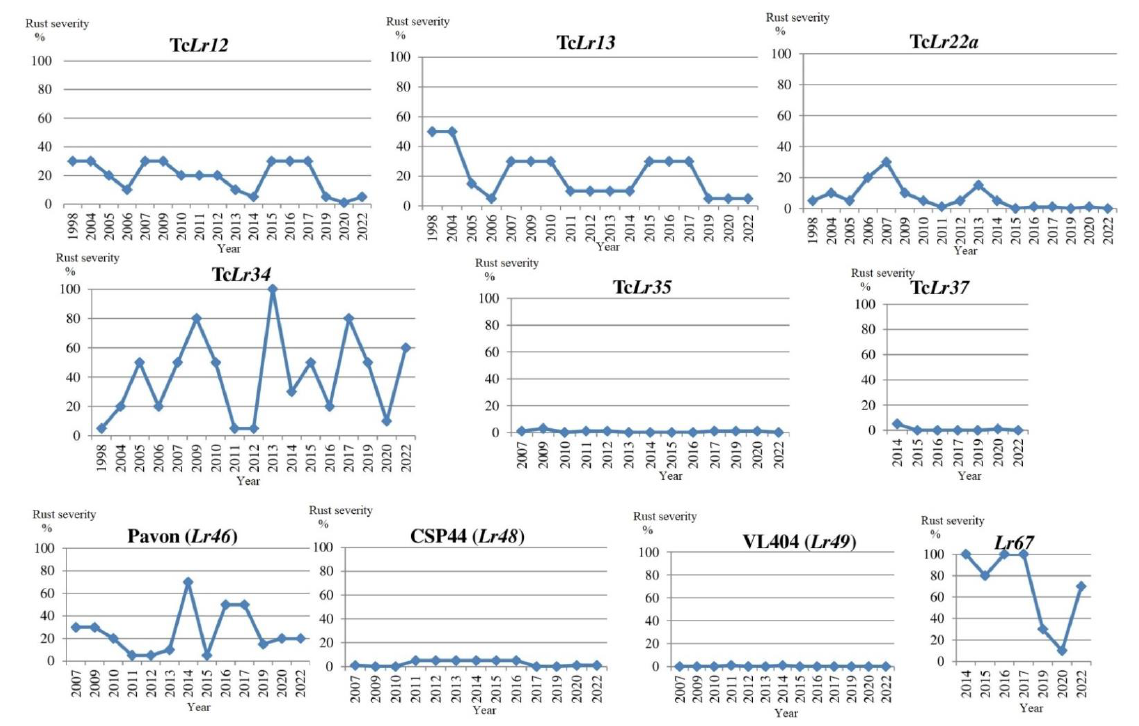
Figure 4. Leaf rust severity on Thatcher lines and cultivars with adult plant resistance genes in the North-Western region of Russia in 1998 – 2022.